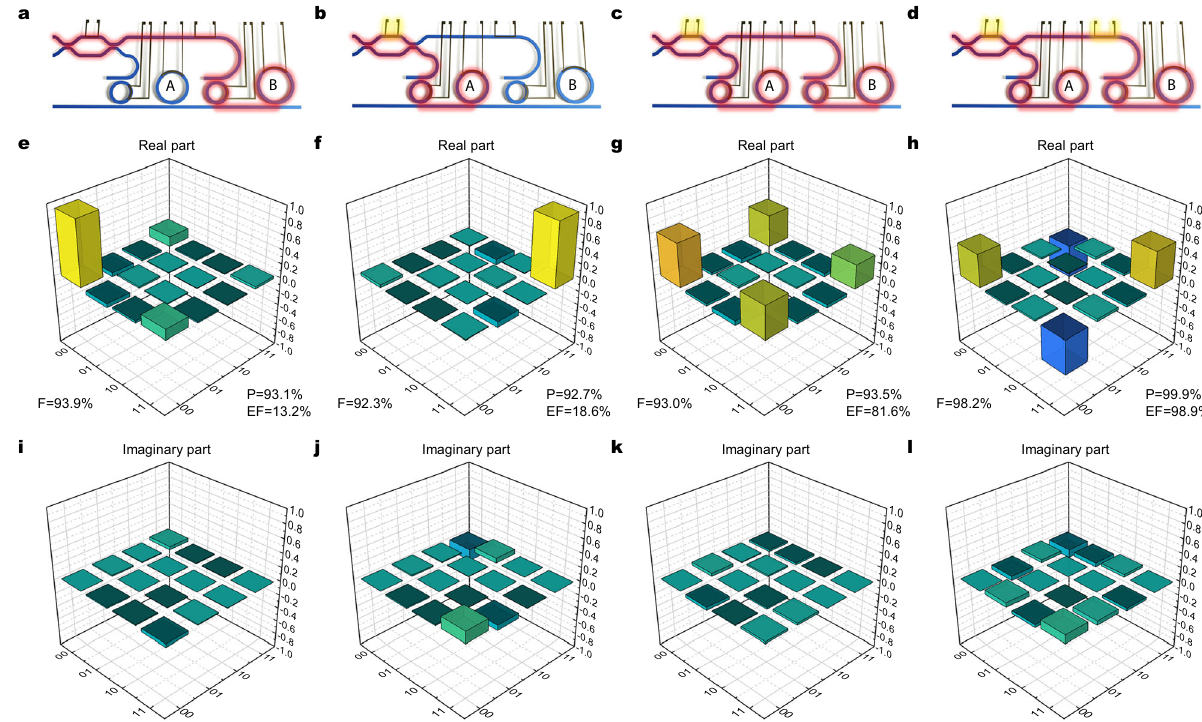
Fig. 5 | Quantum state tomography in the f ∣ 00 i , ∣ 11 ig basis ( Φ con fi guration). Columns from left to right refer respectively to states: ∣ 00 i , ∣ 11 i , ∣ Φ + a – d Device pumping scheme for each of the generated state. The path covered by the pump laser is highlighted in red. The generation rings A and B are selectively addressed by acting on the tunable MZI, while the relative phase of the pump is